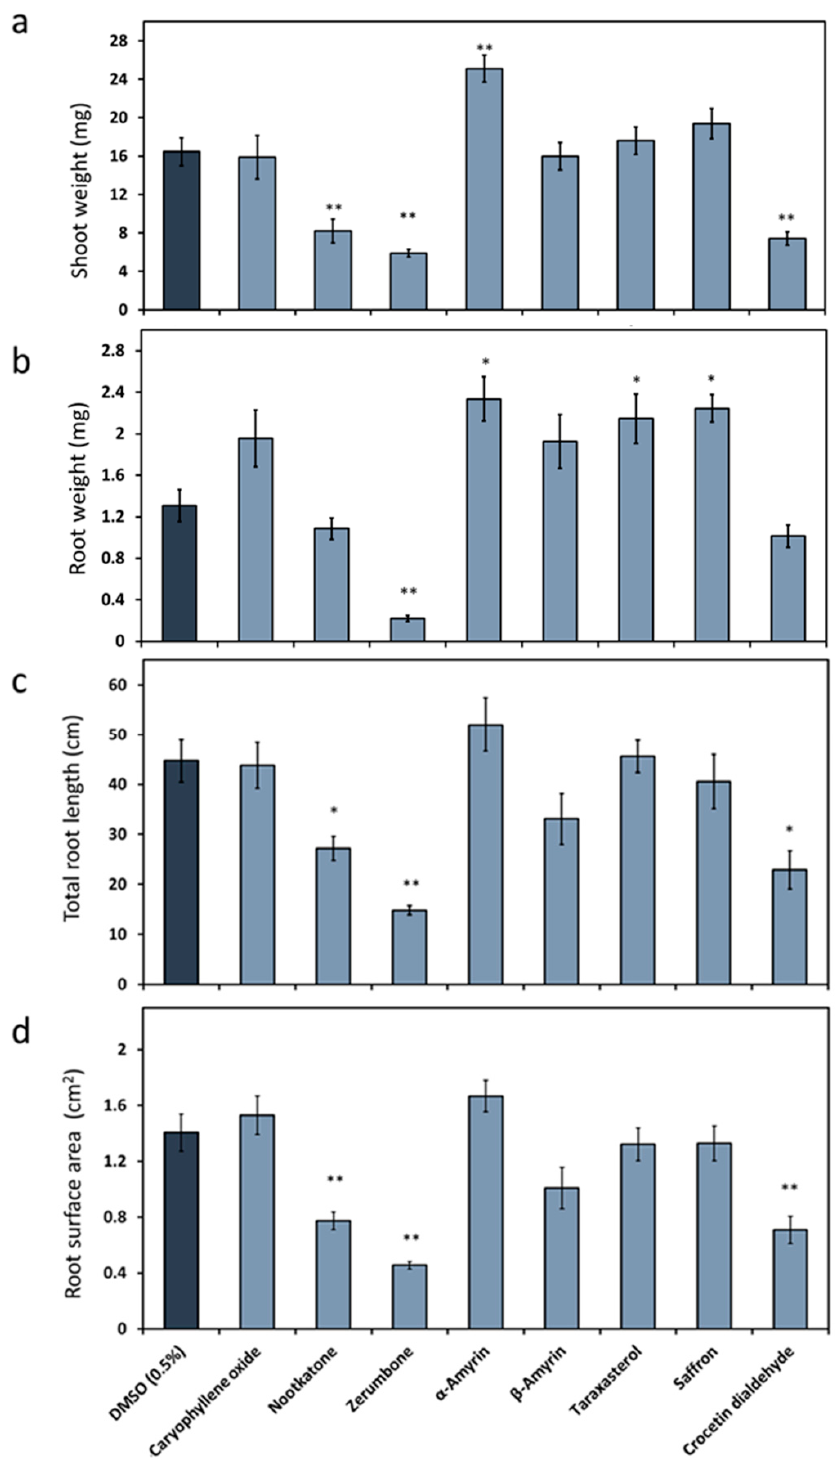
Figure 2. E ff ects of plant terpenoids on Arabidopsis thaliana . A. thaliana was cultured on a medium mixed with plant terpenoids (10 ppm, Figure 1) or dimethyl sulfoxide (DMSO) as the control. The following growth parameters were determined: ( a ) Average shoot weight (mg). ( b ) Average root weight (mg). ( c ) Average total length (cm). ( d ) Average root surface area (cm 2 ). The data are based on three independent experiments. Each bar represents the mean ± SE of n = 12. The asterisk marks indicate significant di ff erences to the control based on a t -test (* p < 0.05 and ** p < 0.01).